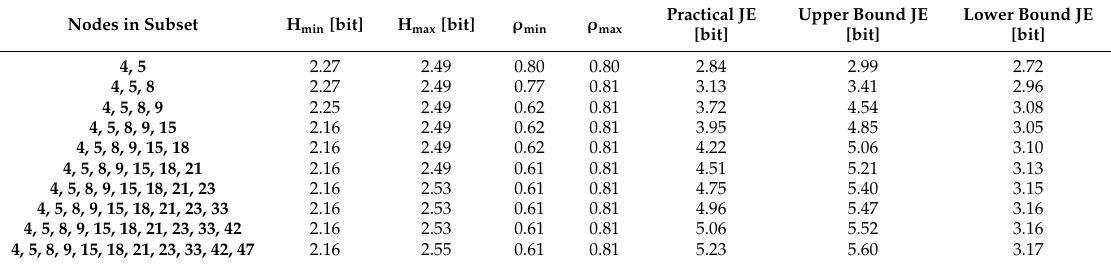
Table 3. Practical, upper bound and lower bound joint entropy (JE) of subsets from dataset 1. Nodes in